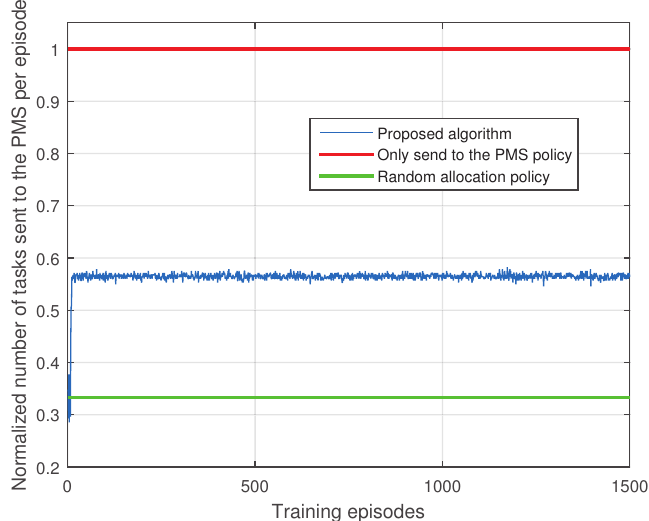
Figure 5. Comparison with benchmark polices in terms of normalized number of tasks sent to the PMS per episode.